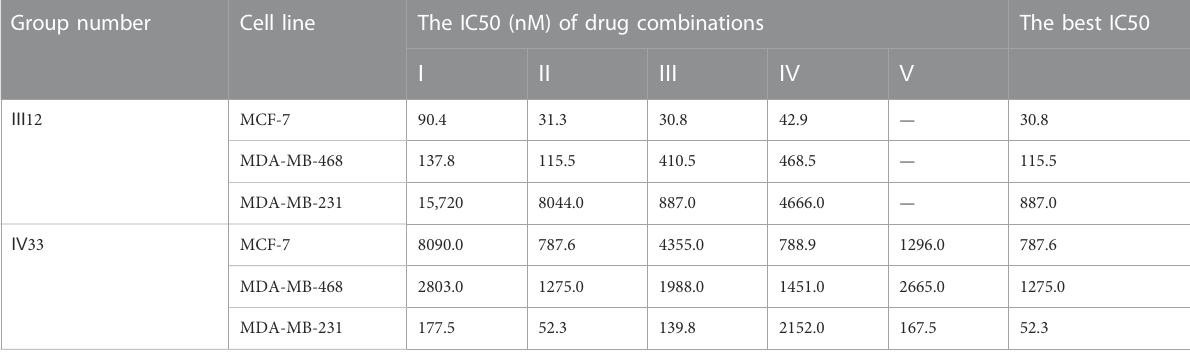
TABLE 9 The anti-cancer effect of Ⅲ 12 and Ⅳ 33 on MCF-7, MDA-MB-231 and MDA-MB-468 cells. Group